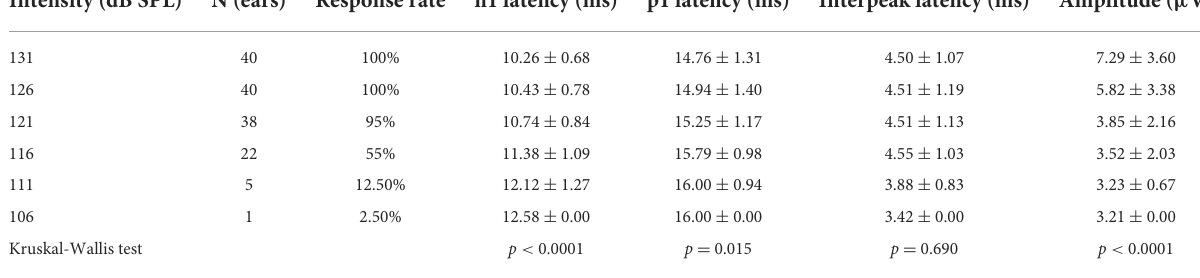
TABLE 3 The ACS-oVEMP with decreasing acoustic stimulation intensity in adults. Intensity (dB SPL)